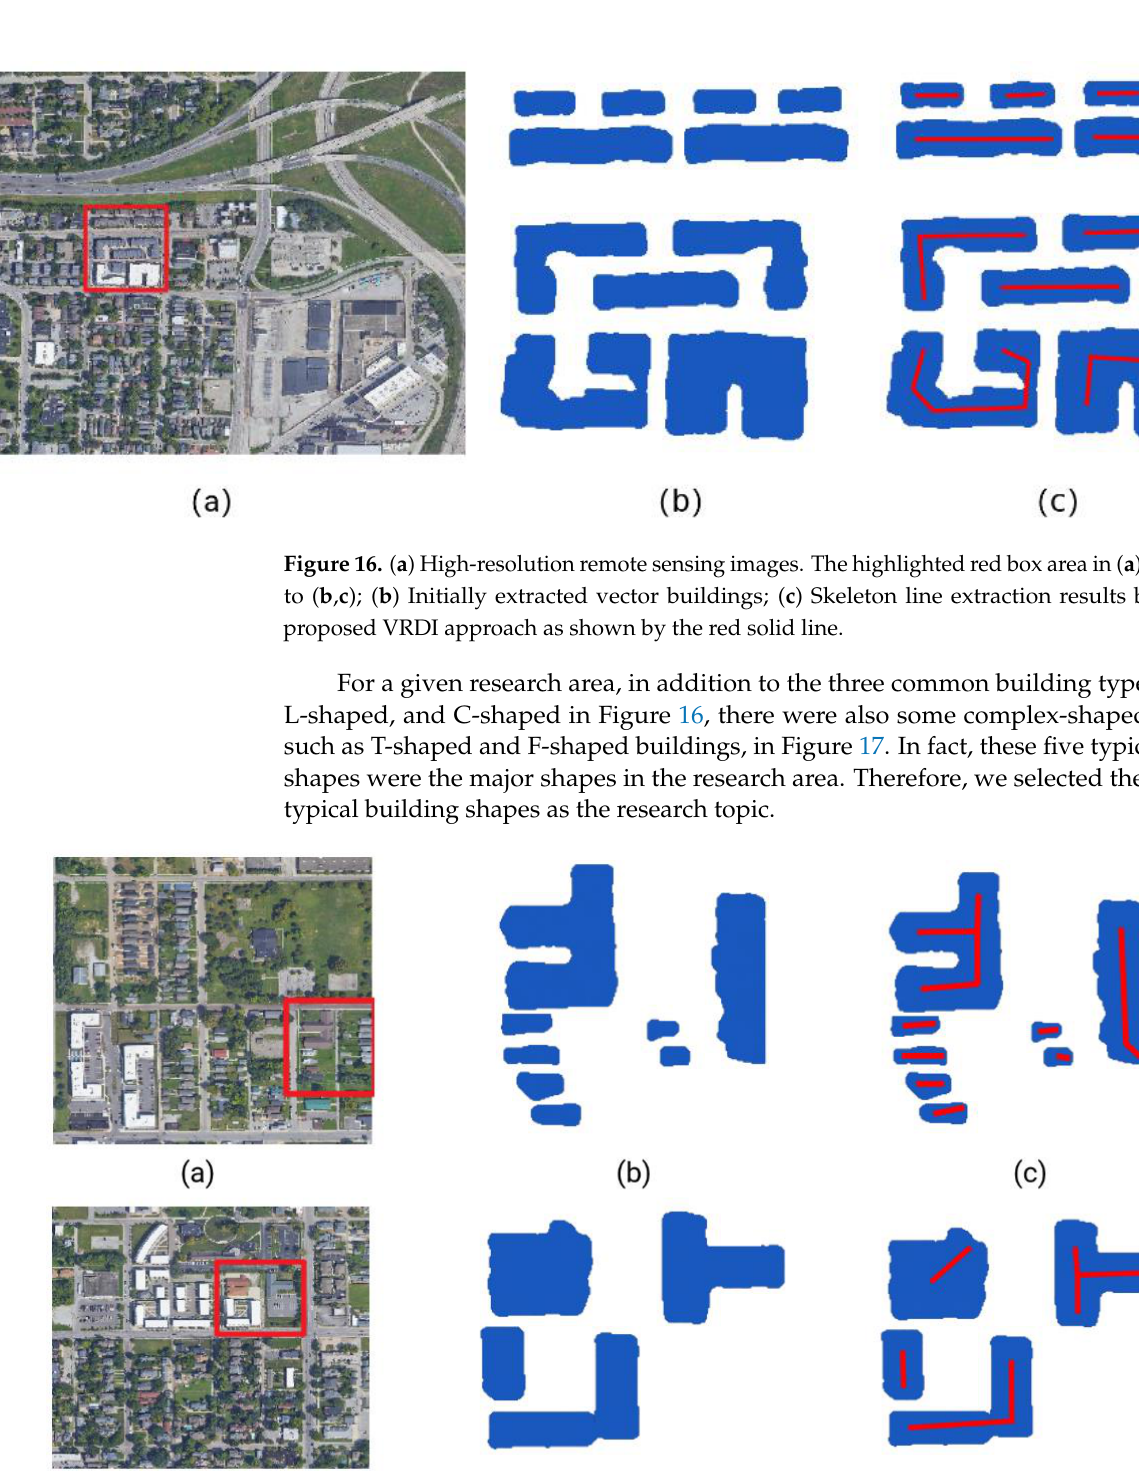
13 of 19 Figure 15. Skeleton line segment DP simplification results with different threshod; ( a ) L-shaped building with a threshold of 1 m; ( b ) L-shaped building with a threshold of 3 m; ( c ) C-shaped building with a threshold of 1 m; ( d ) C-shaped building with a threshold of 3 m. 4. Experimental Results and Analysis 4.1. Experimental Results The effectiveness of the proposed skeleton line extraction method was verified by considering the complex vector buildings initially extracted from high-resolution remote